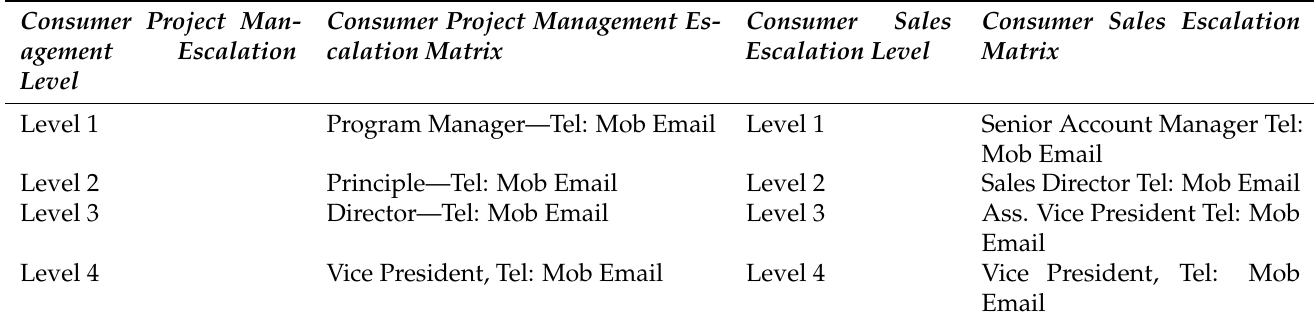
Table 12. Consumer Escalation